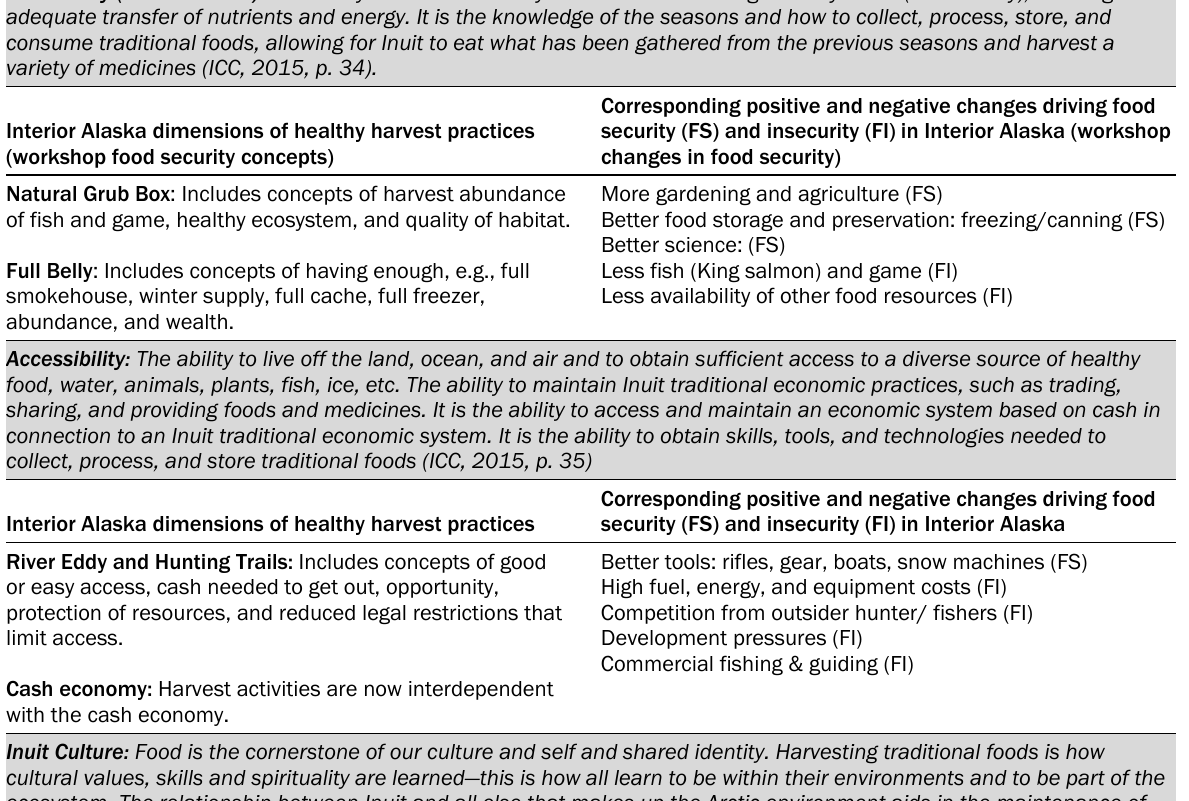
Table 1. Comparing the Inuit Circumpolar Council (ICC)’s Six Dimensions of Food Security to Components of Healthy Traditional Harvest Practices of Rural Indigenous Communities in Interior Alaska Identified in the